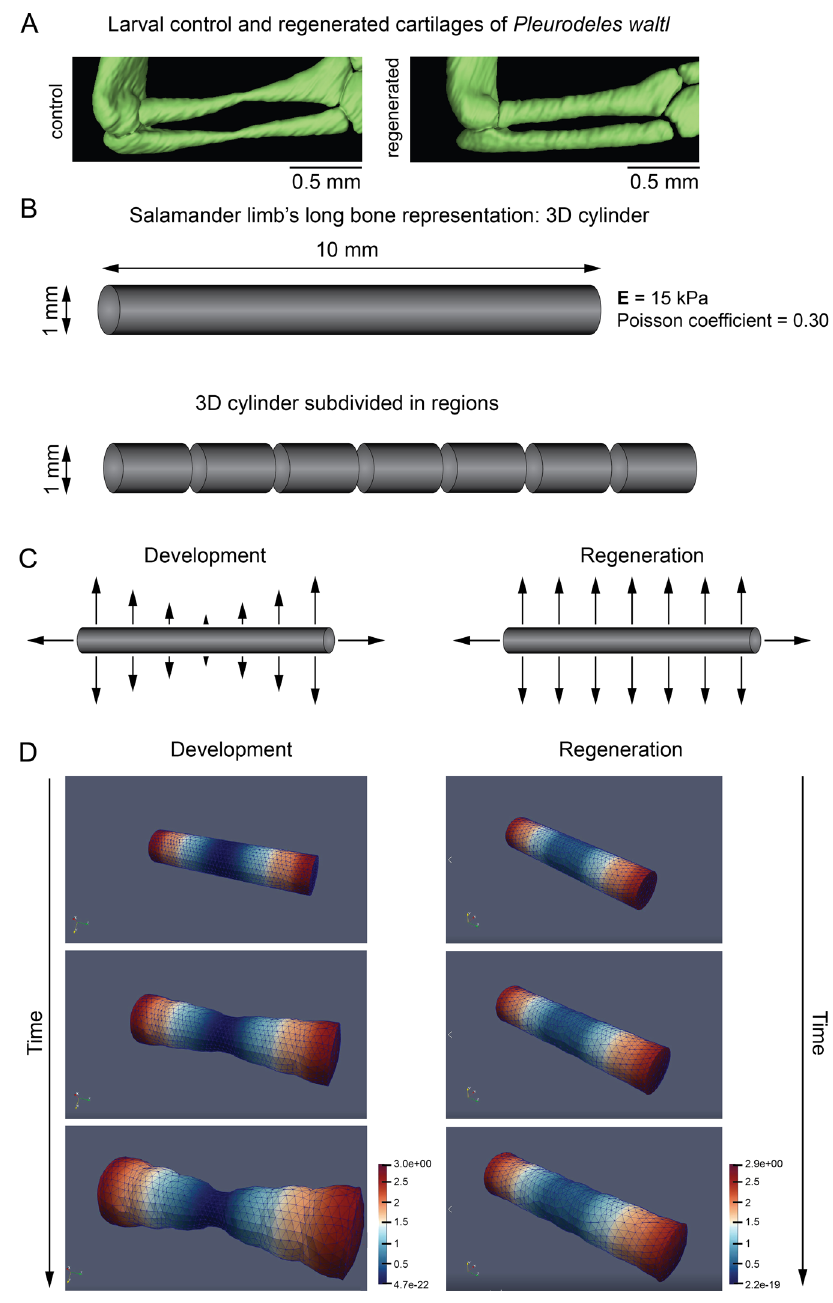
Fig. 5 | Computational simulation of long bone shaping during development and regeneration. A Differences in shape between normally developing (left) and regenerated (right) limb cartilages of the larval Pleurodeles waltl . B Long bone represented by a 3D cylinder. The geometrical and material properties used are speci fi ed. C Tissuegrowthisdescribedasregion-speci fi cinternalpressures.Tissues